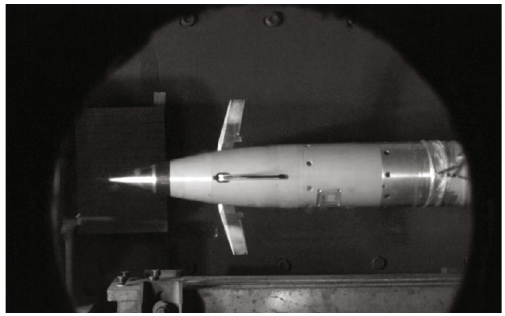
Figure 2: The state that the rudder is fully opened but not yet ruddered.